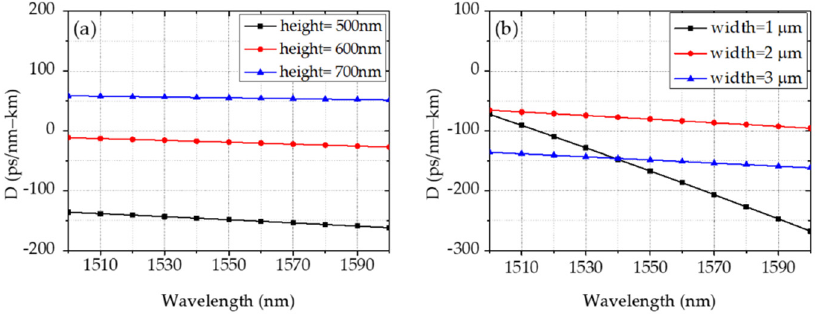
Figure 1. Waveguide dispersion with different geometries. ( a ) Dispersion of waveguides with varying heights. ( b ) Dispersion of waveguides with varying widths.